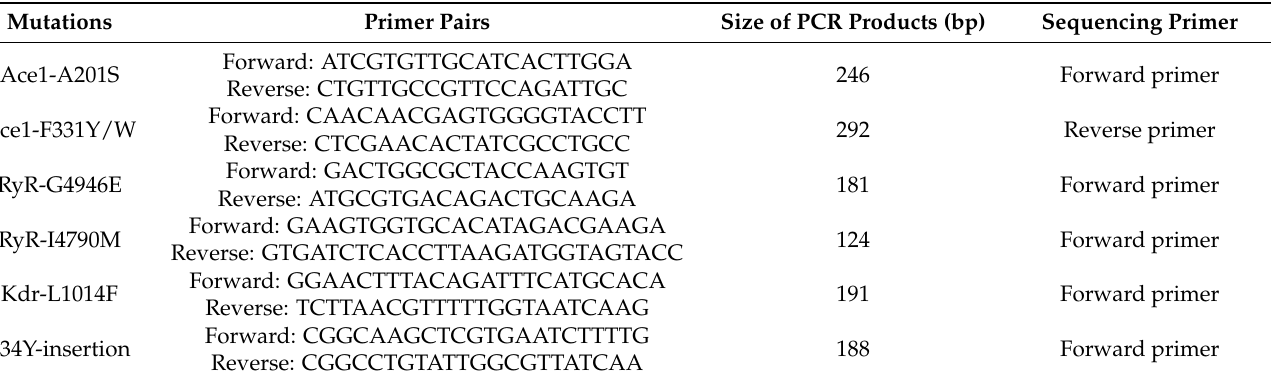
Table 3. The primer pairs used for amplification of a region containing key SNPs and the primers used in